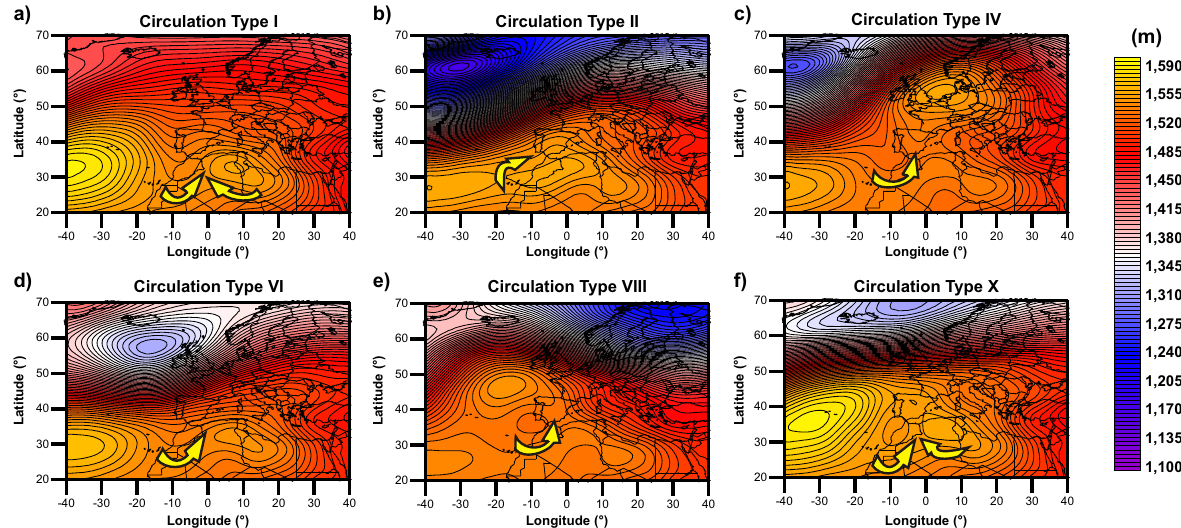
Fig. 5 Synoptic maps describing ADO circulation types. Composite synoptic maps of 850 hPa geopotential height at 12 UTC (m) for ADO circulation types (CT-I ( a ), CT-II ( b ), CT-IV ( c ), CT-VI ( d ), CT-VIII ( e ) and CT-X ( f )) resulting from the circulation classi fi cation process, for the period 1948 – 2020. Arrows indicate the prevailing advection of the air masses towards the IP-BI